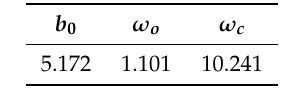
Table 3. Simulation parameters of the ILADRC-based